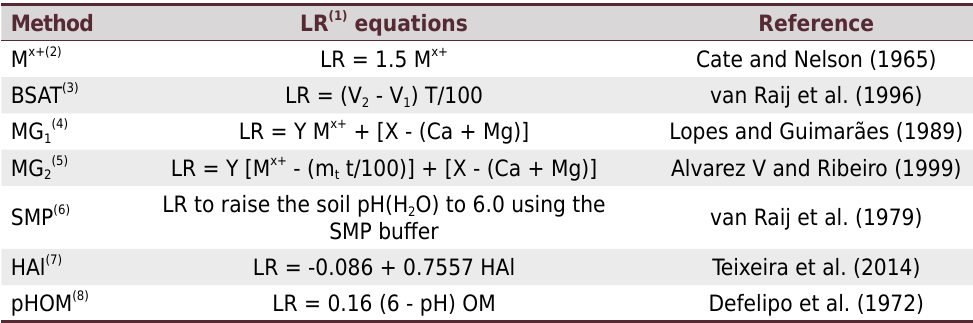
Table 1. Traditional methods to determine the lime requirement (LR) used in the 60 d incubation